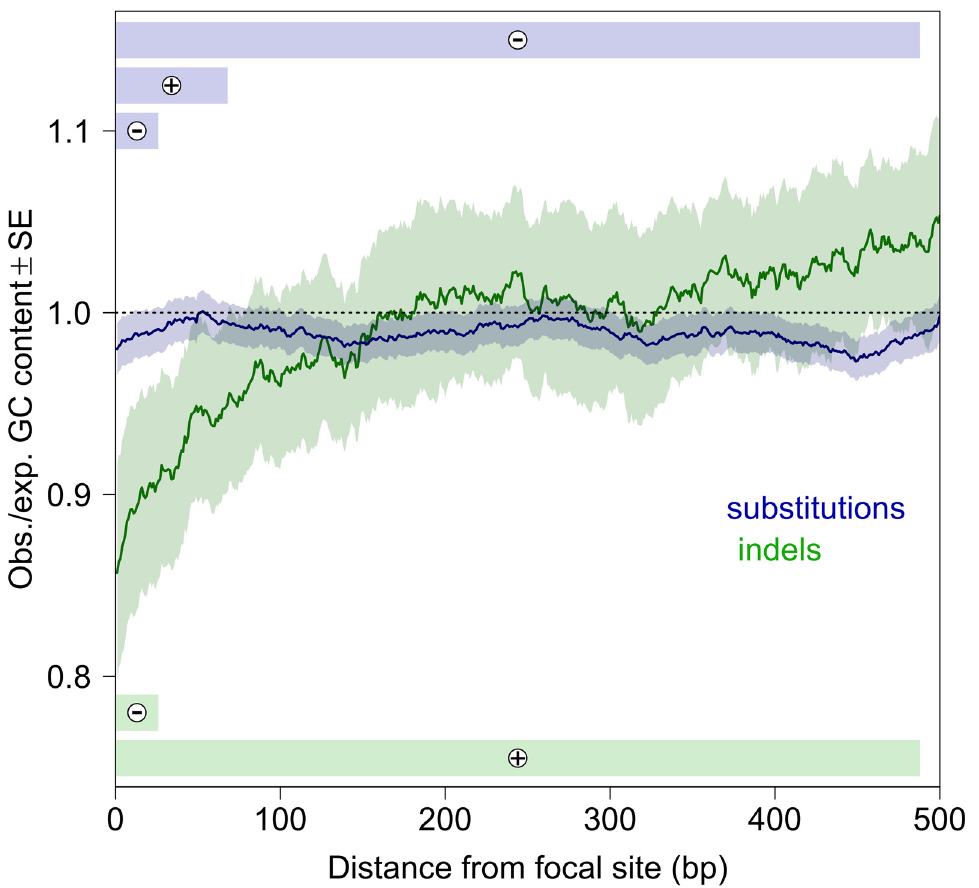
Fig 4. Substitution and indel rates are sensitive to local GC content. Lines represent sliding window averages of GC content surrounding mutant relative to nonmutant sites (up to 500 bp on either side), with bootstrap standard errors. Bars depict the local regions where GC content best predicts the occurrence of mutations, based on the AIC (Akaike information criterion) values of logistic models, with the sign of the effect shown on each bar. The sliding window plot does not account for the spatial correlation in GC content, whereas the logistic model does, which can explain the apparent differences. See S1 Data for plot